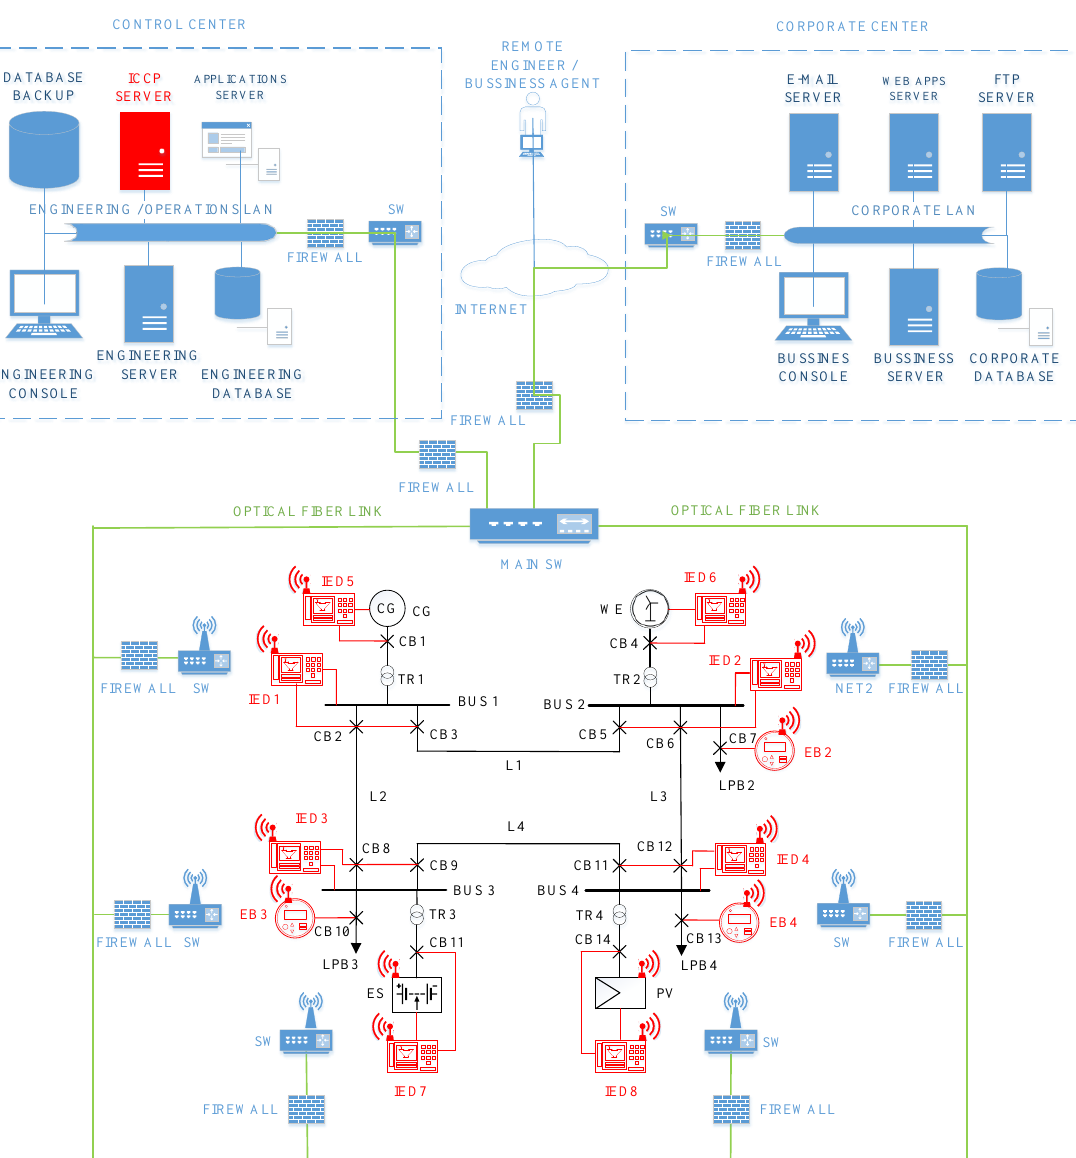
Figure 1. These authors in [12] applied FMECA analysis, combining power and cyber equipment in a distribution grid.